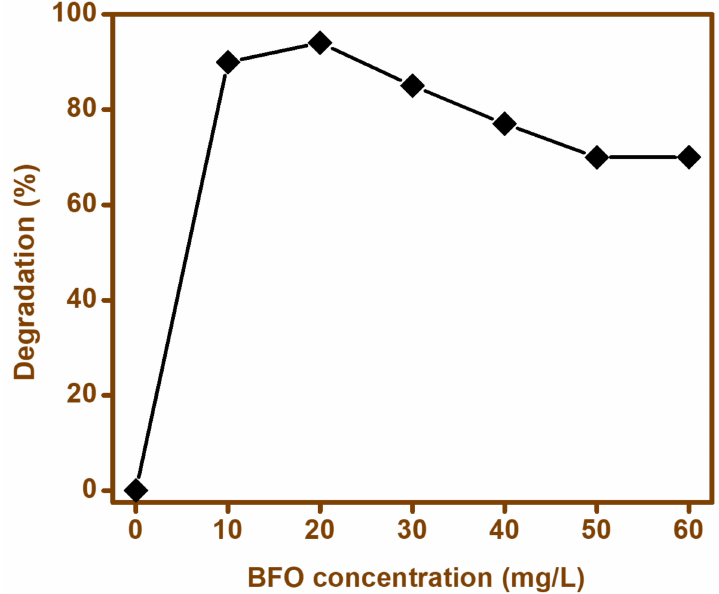
Figure 10. Effect of BFO concentration for the degradation of cefixime